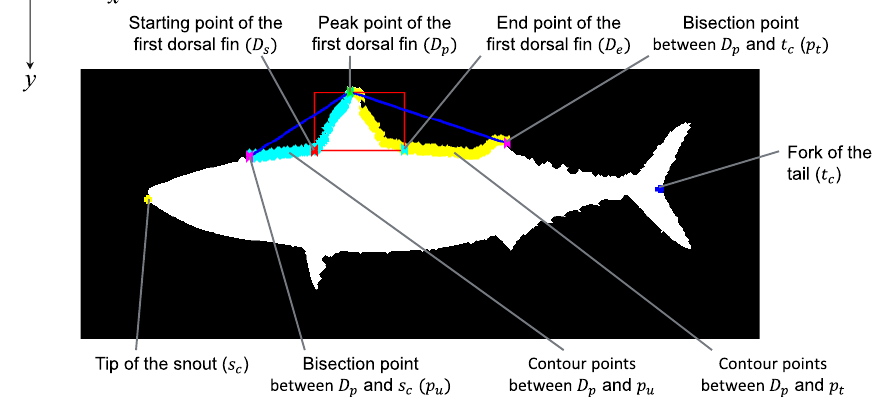
Figure 7. Feature points used to detect the first dorsal fin.